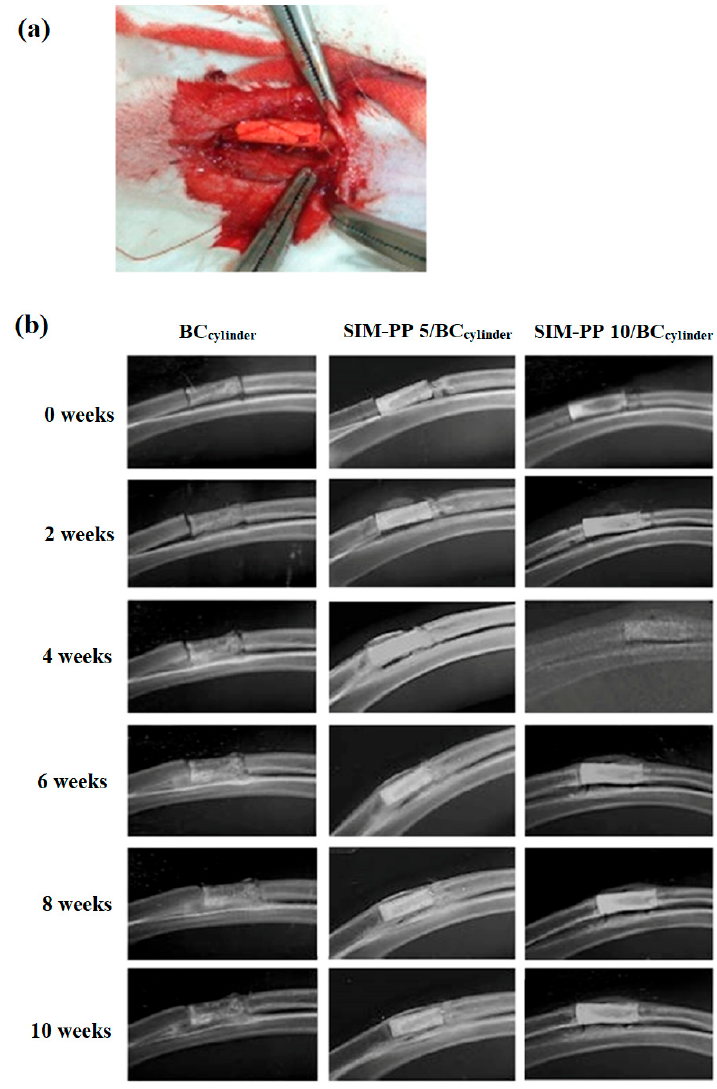
Figure 5. A representative radial bone defect rabbit model is shown in experimental photograph ( a ). The radiography study was performed to evaluate ( b ) the 10-mm nonunion radial bone defect rabbit model at 0, 2, 4, 6, 8 and 10 weeks after implantation of BC cylinder samples ( ϕ 1 3.5 mm; ϕ 2 1.5 mm; h 10 mm), 5.0 μ mol of SIM in SIM-PP/BC cylinder and 10.0 μ mol of SIM in SIM-PP/BC cylinder